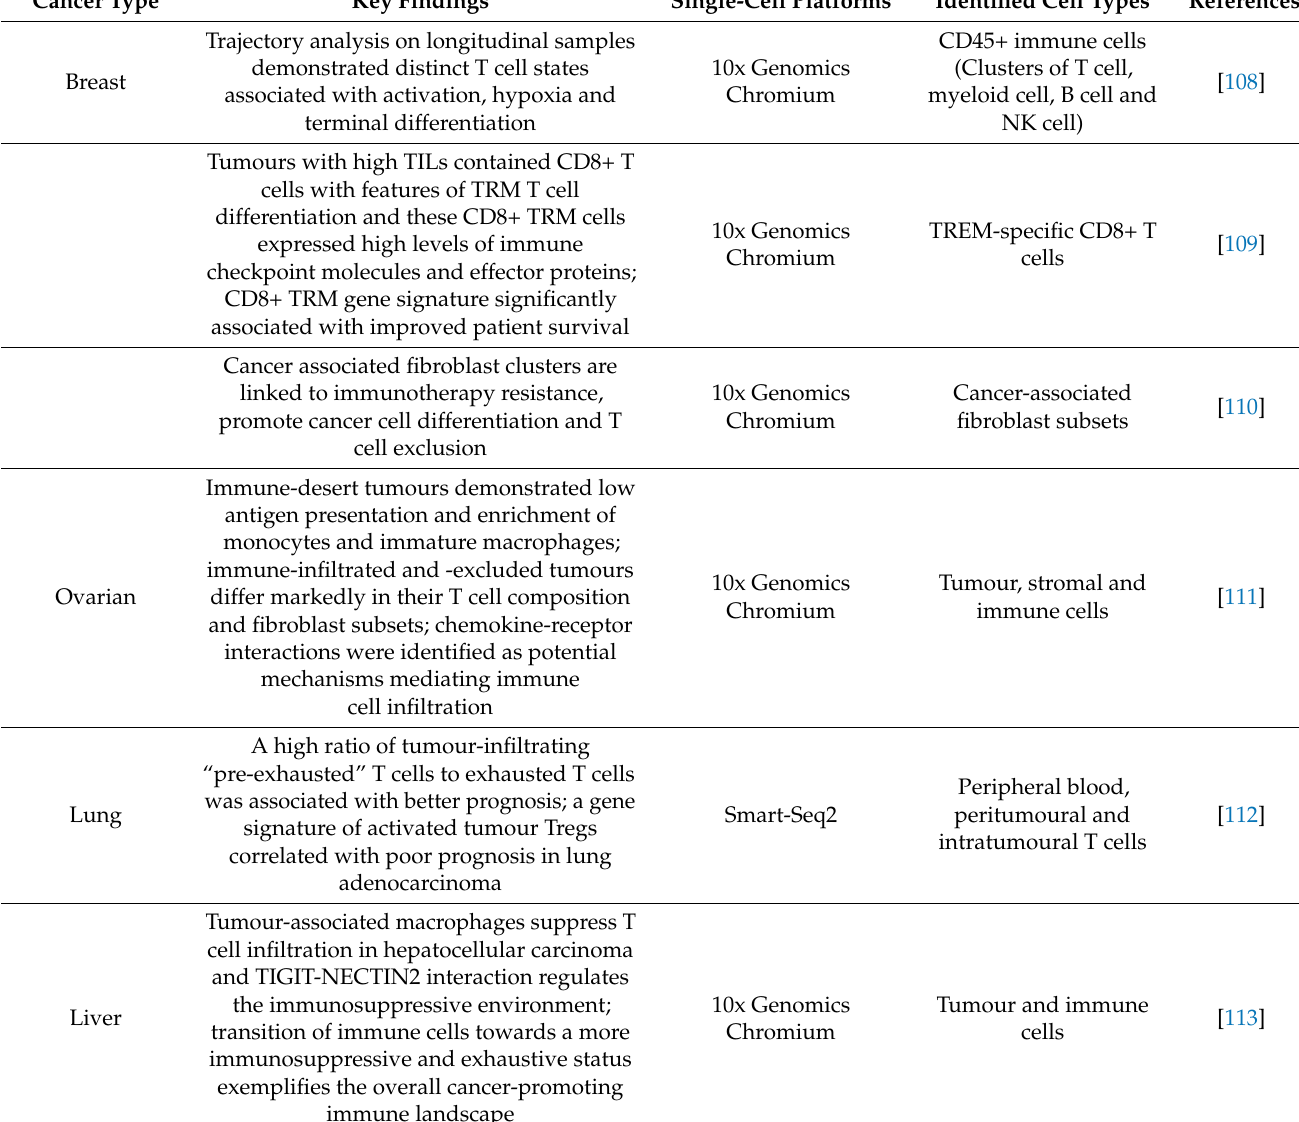
Table 4. Translational insights of immuno-oncology of other cancer types from single-cell analyses. Cancer